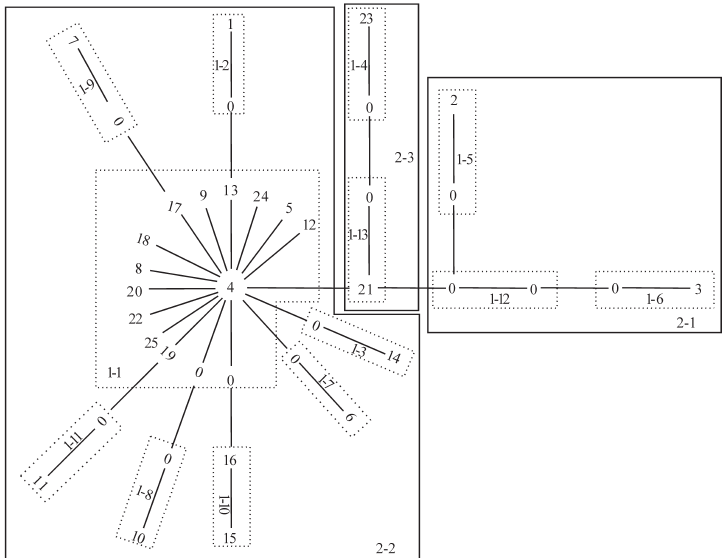
the sample. Each line represents a single mutational step that connects two haplotypes. Dashed boxes enclose one-step clades, which are referred to as ‘1- x ‘, where x is the number that identifies the clade, while solid boxes enclose two-step clades (‘2- x